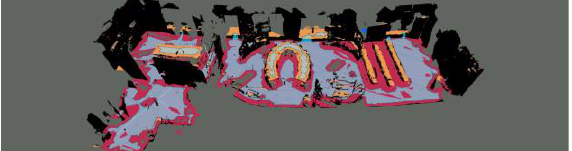
Figure 4: Navigable space represented in a